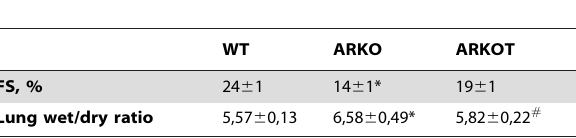
Table 2. Cardiac function and lung water